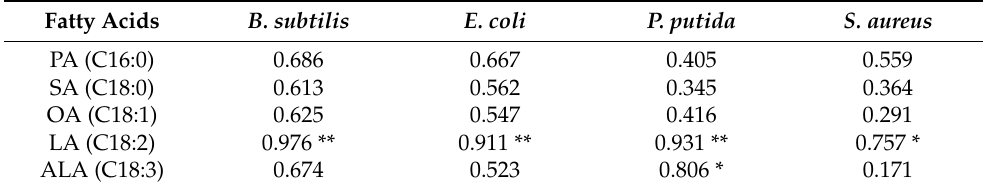
Table 4. Correlation coefficients (Pearson r) between the antimicrobial activity against different food-contaminants and palmitic acid (PA), stearic acid (SA), oleic acid (OA), linoleic acid (LA) and α -linolenic acid (ALA) contents of hydrolyzed oil